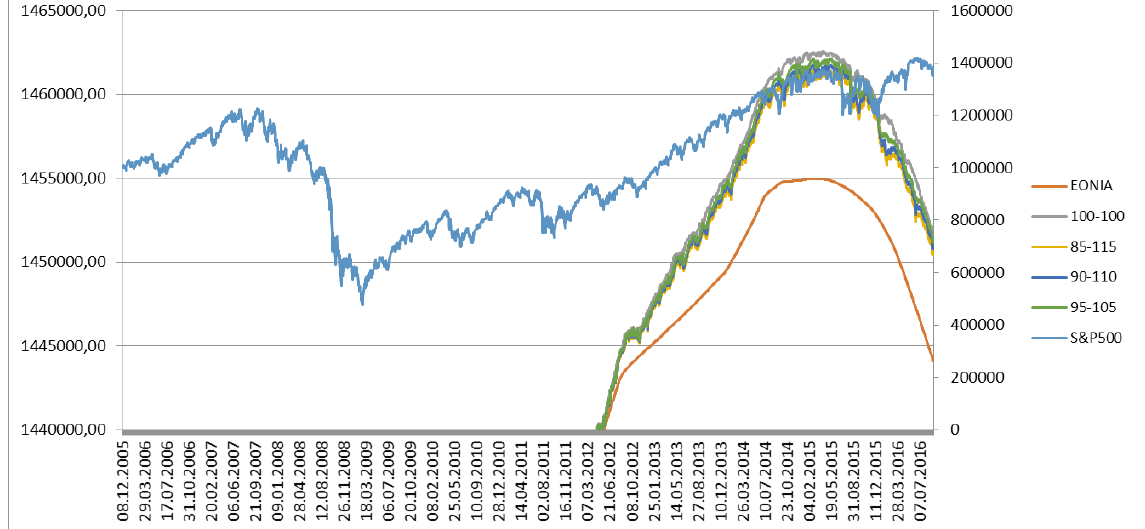
Figure 7. Implied volatility (VIX) as a part of the initial scenario for all volatility